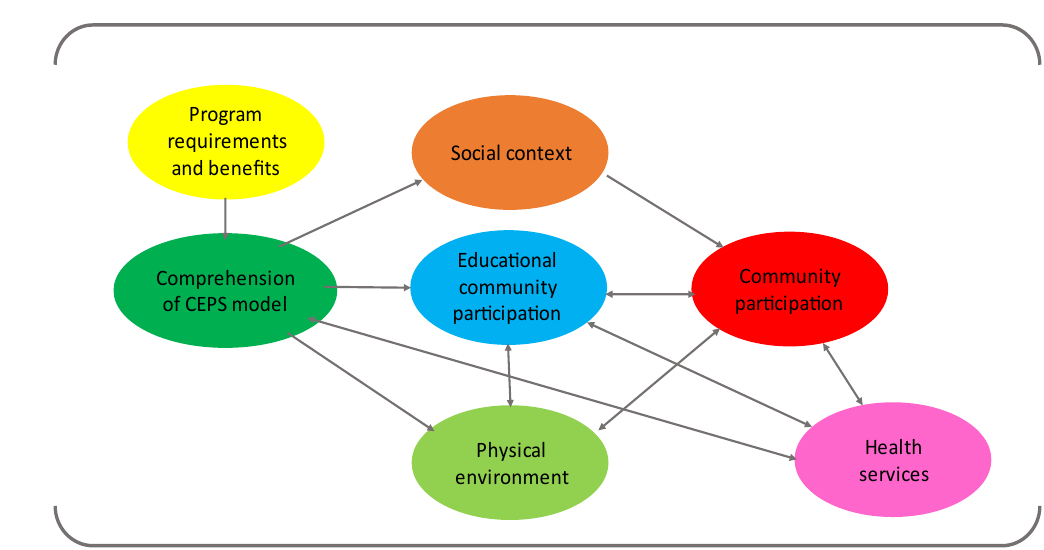
Figure 1. Model for development of